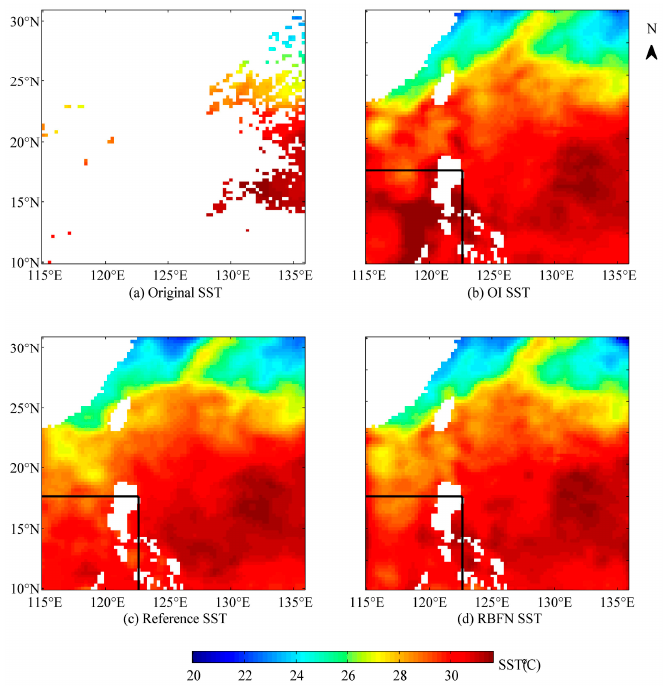
Figure 9. The distributions of ( a ) original SST samples; ( b ) OI SST; ( c ) reference SST; and, ( d ) RBFN SST on 18 June 2014. The region outlined by the square is used for comparison in detail. White areas in the images indicate no data or land.